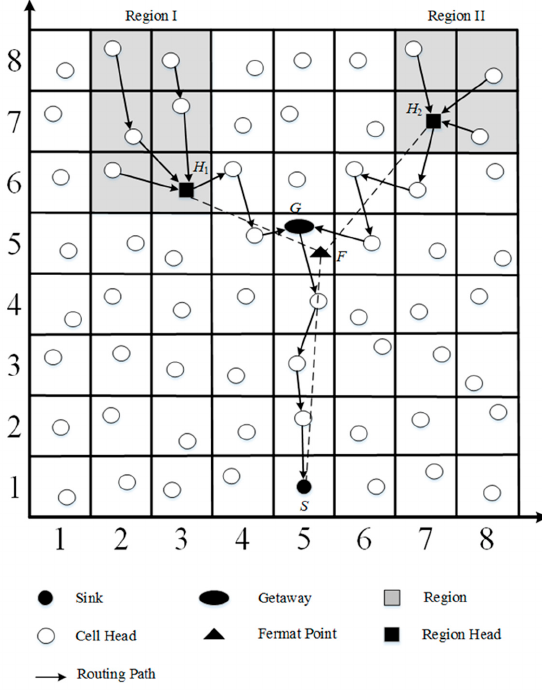
Figure 4. Gateway selection.